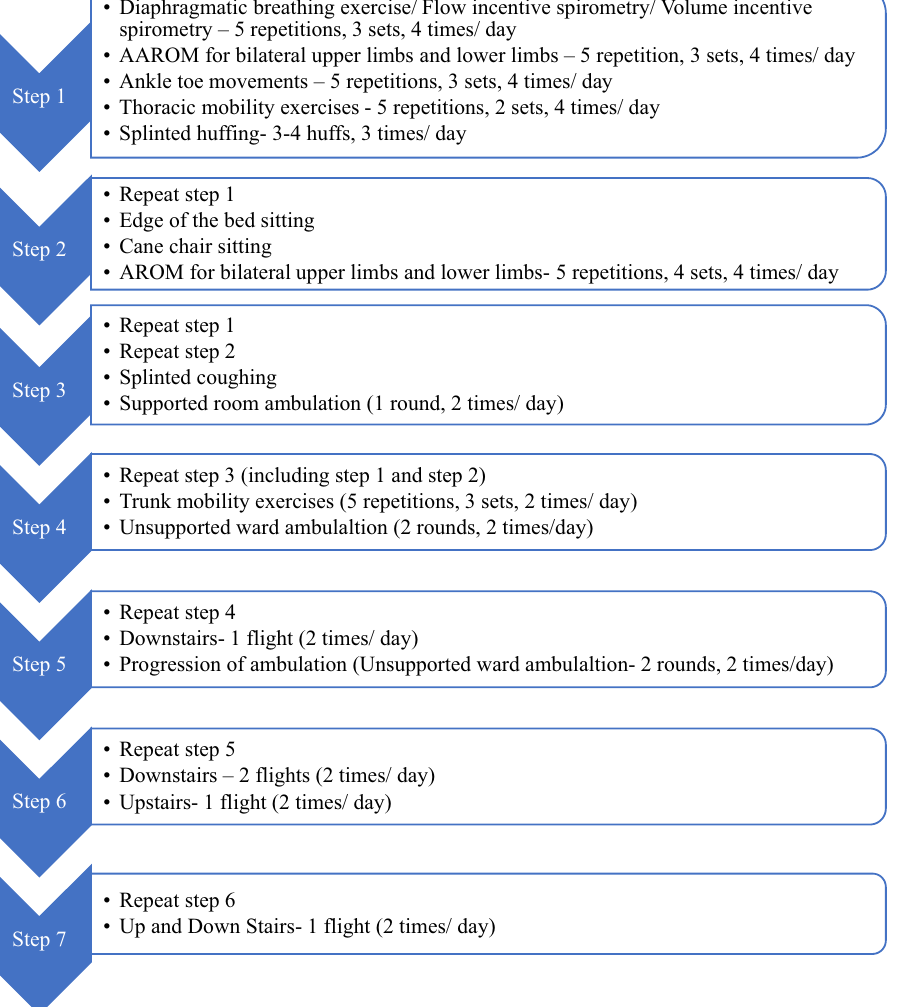
Figure 8. Phase 1 cardiac rehabilitation program (stepwise protocol for 7 days until